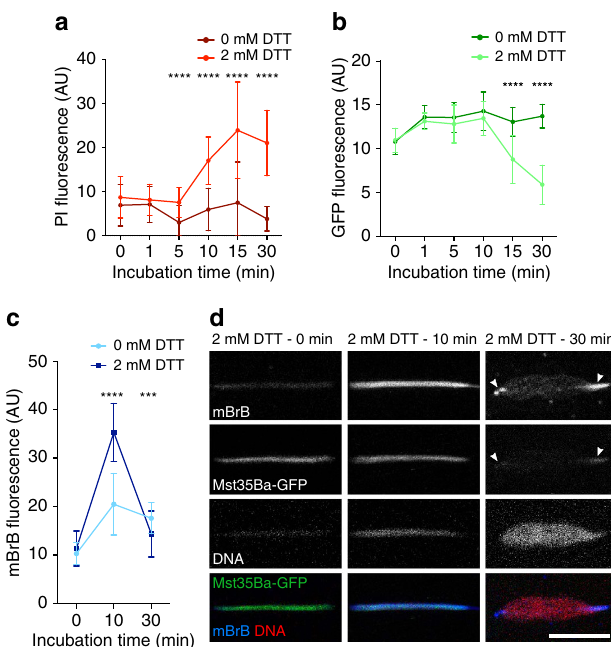
Figure 4 | DTT induces SNBP eviction and sperm nuclear decondensation in vitro . Mst35Ba-GFP sperm dissected from seminal vesicles were incubated with DTT for the indicated time and stained with propidium iodide (PI, red) and mBrB (blue). ( a – c ) Quantification of PI ( a ), native GFP ( b ) and mBrB ( c ) fluorescent signals in representative experiments (Mann–Whitney test. *** P o 0.001. **** P o 0.0001). Error bars indicate SD calculated for 29 analysed nuclei for each time point. ( d ) Confocal images of Mst35Ba-GFP sperm nuclei incubated with DTT for the indicated time. Arrowheads indicate condensed nuclear regions positive for both mBrB and Mst35Ba-GFP. Scale bar: 5 m